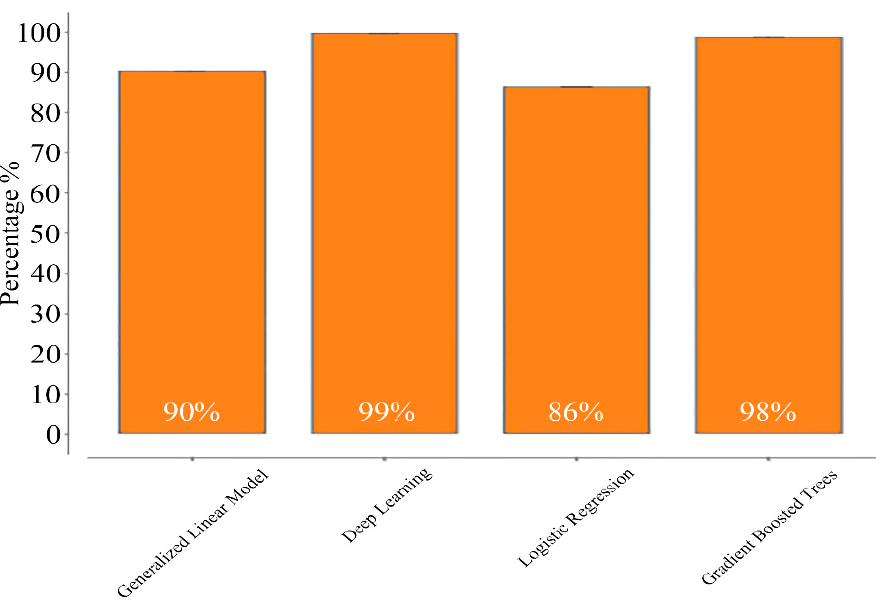
Figure 2. Venue Classification into 10 classes using Machine Learning.